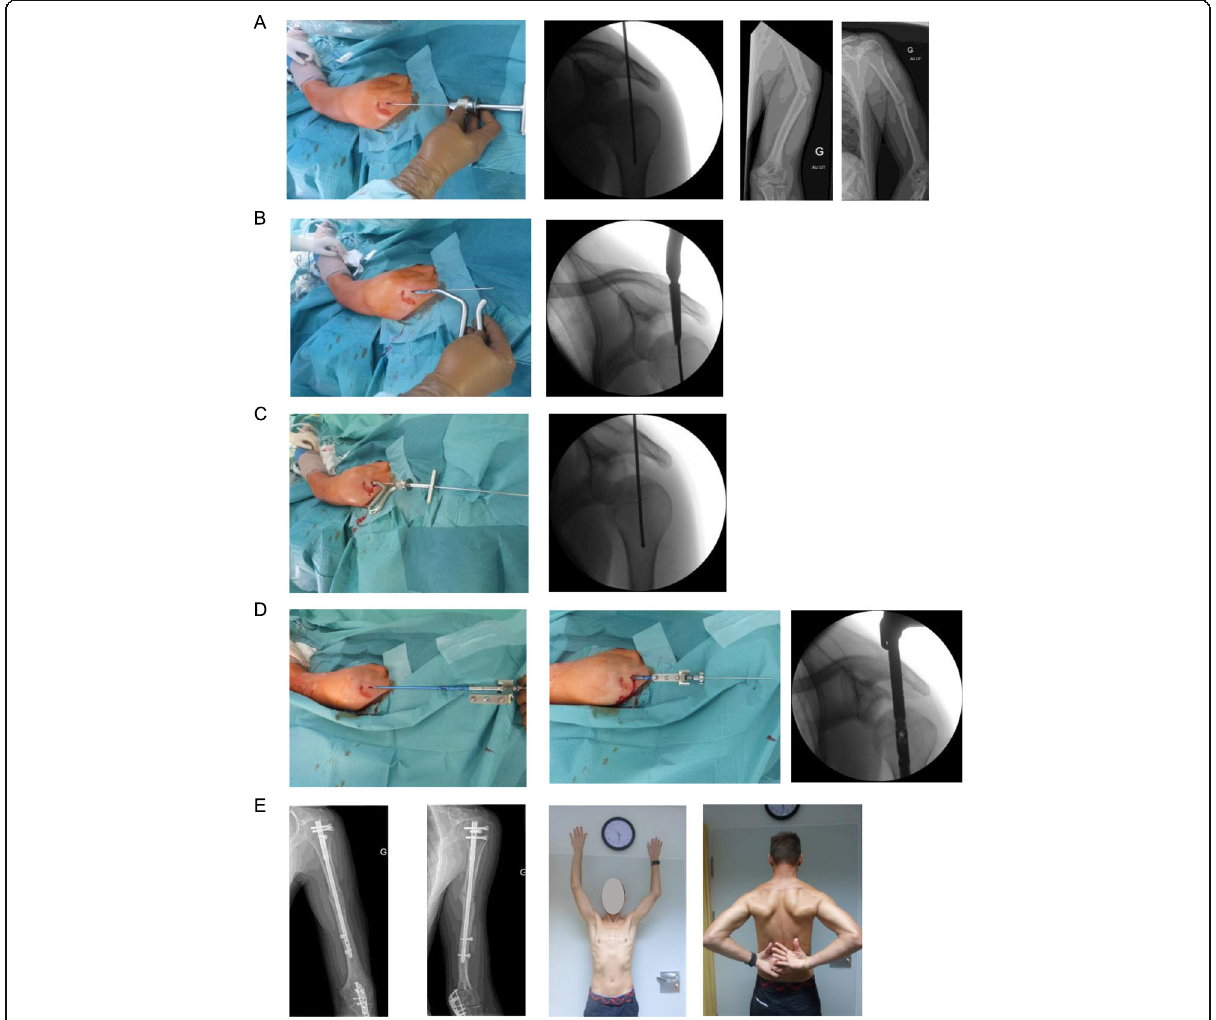
Fig. 1 Combined diaphyseal and olecranon fracture. Superficial skin laceration next to the portal of Neviaser. A 1 cm skin-incision is made in the triangle between the clavicle, acromion and scapula spine. A Kirschner wire is advanced to the zenith of the humeral head ( a ). Once the entry point on the humeral head is established a canulated awl is advanced splitting the supraspinatus muscle fibres longitudinally and opening the the humeral head ( b ). With the awl in place the Kirschner wire is replaced by a longer guide ( c ) wire which is then used to advance the straight nail ( d ). Clinical and radiological follow-up 10 weeks after surgery ( e